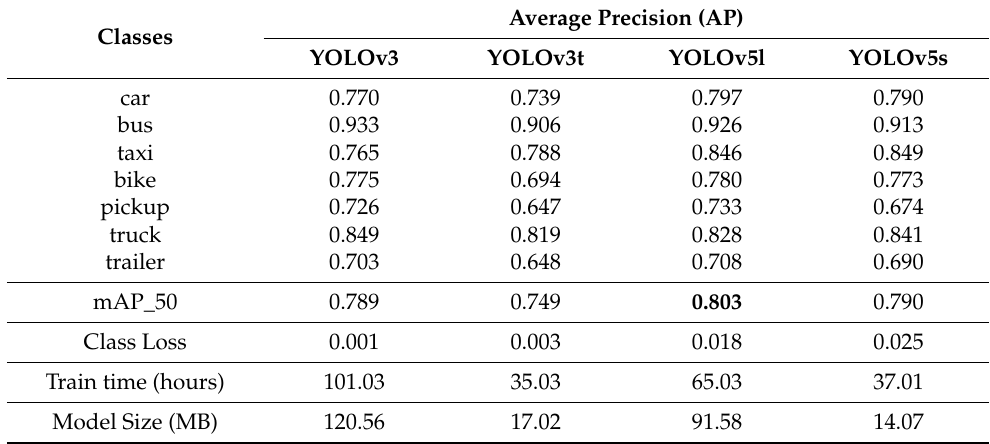
Table 2. Performance of the YOLO networks trained on TR1 evaluated on the validation data of